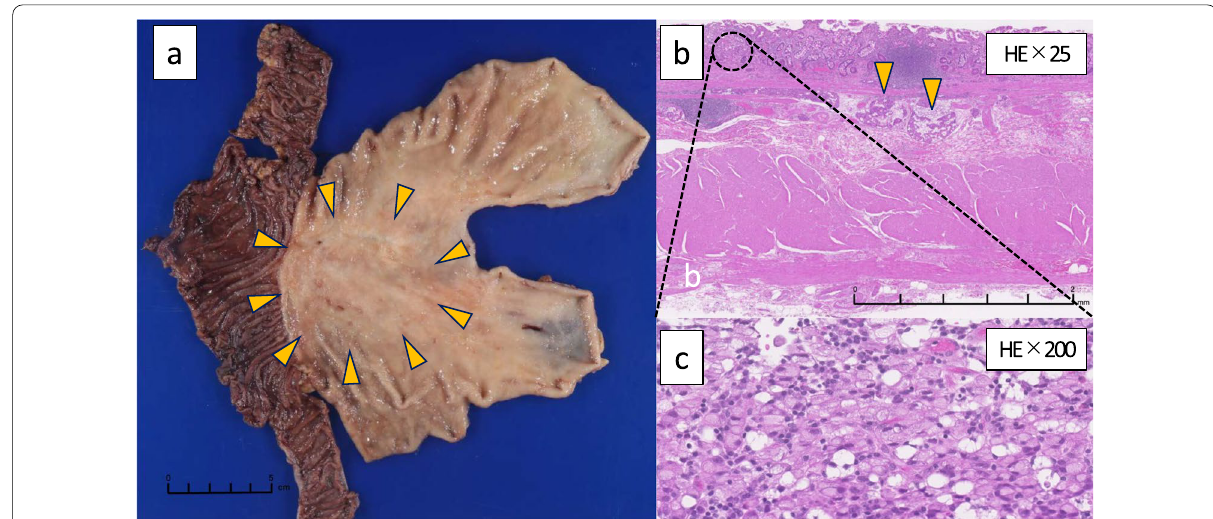
Fig. 4 a Macroscopic findings of the resected specimen of the gastric lesion was a type 5 tumor based on the Borrmann classification, 73 55 mm, and was located in the gastrojejunal anastomosis (arrow). b Histological findings of gastric cancer showing invasion of cancer cells × into the layer of tissue under the mucosa, and masses of cancer cells in the lymphatic vessels ( Signet-ring cell carcinoma (SRCC) and poorly differentiated carcinoma were observed in the mucosa of the stomach (